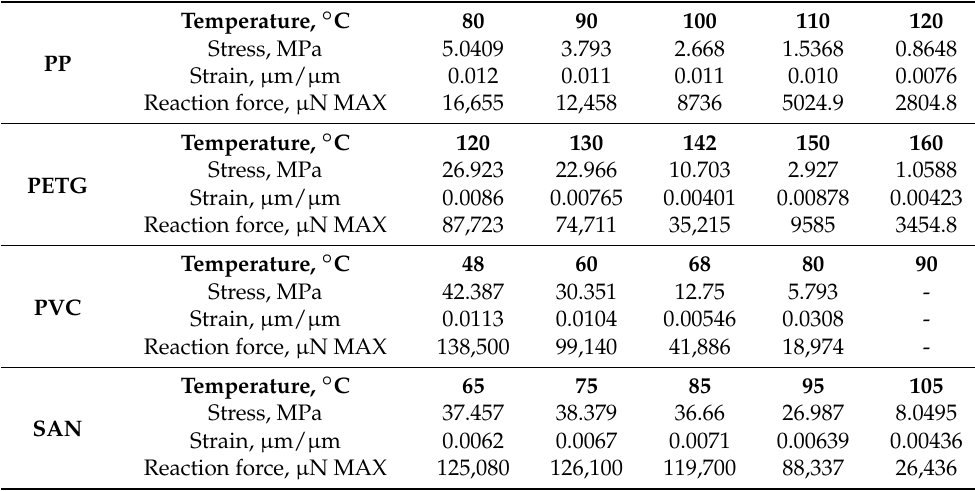
Table 4. Simulation results of thermoplastics’ behavior during thermal